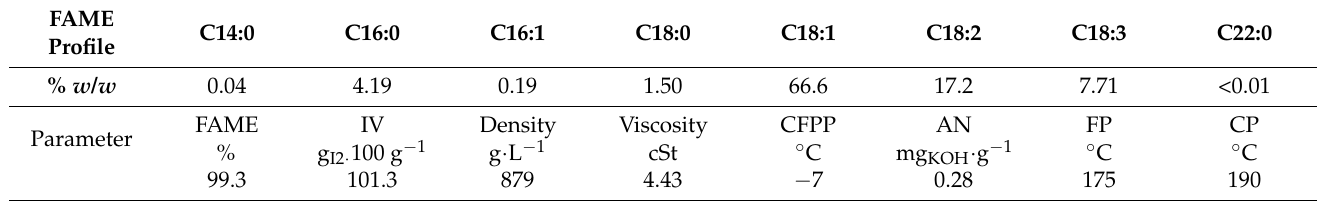
Table 9. Quality parameters of rapeseed biodiesel through heterogeneous catalysis (NaNO 3 /SiAl 20/1) with methanol. FAME